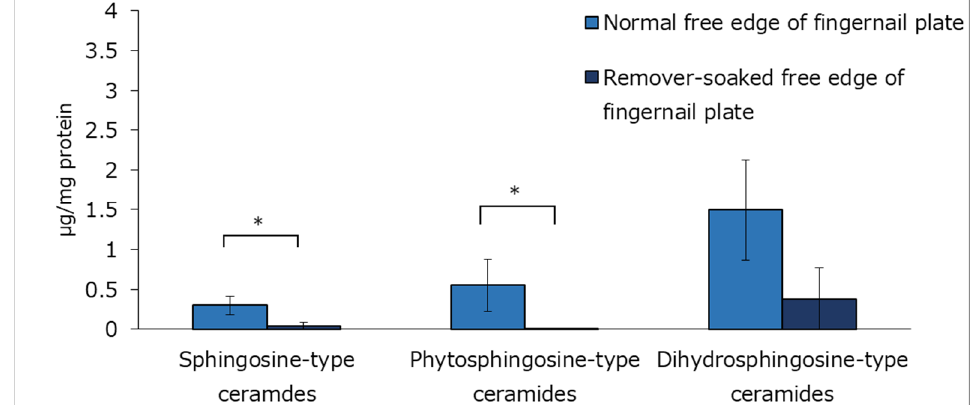
Figure 3. Ceramide content of the normal free edges of fingernail plates and the nail polish remover soaked free edges of fingernail plates measured by HPLC. n = 3, means ± standard deviations, *: p < 0.05.